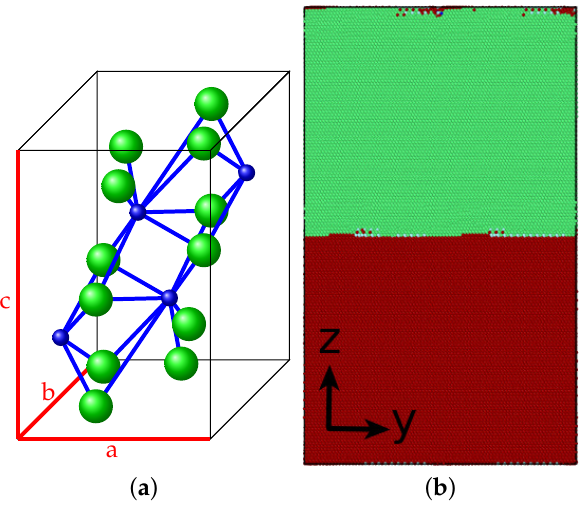
Figure 1. ( a ) Orthorhombic cementite unit cell (Green: Fe; blue: C). ( b ) Setup of simulation system for a ferrite (green)/cementite (red) bicrystal. The interface lies in a x – z